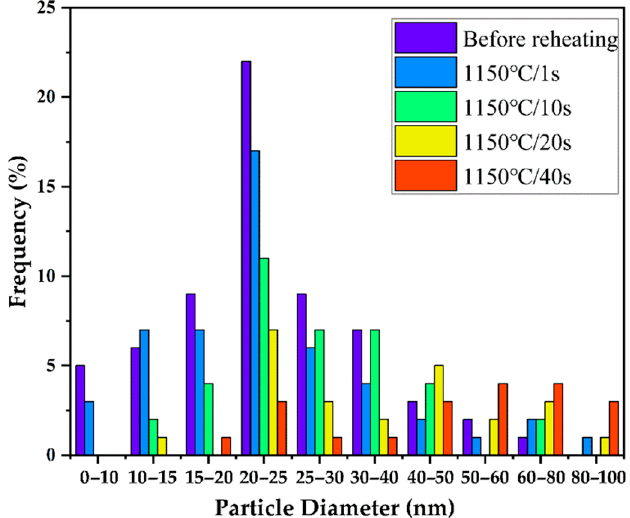
Figure 6. Particle size distribution statistics of precipitates at different holding times.